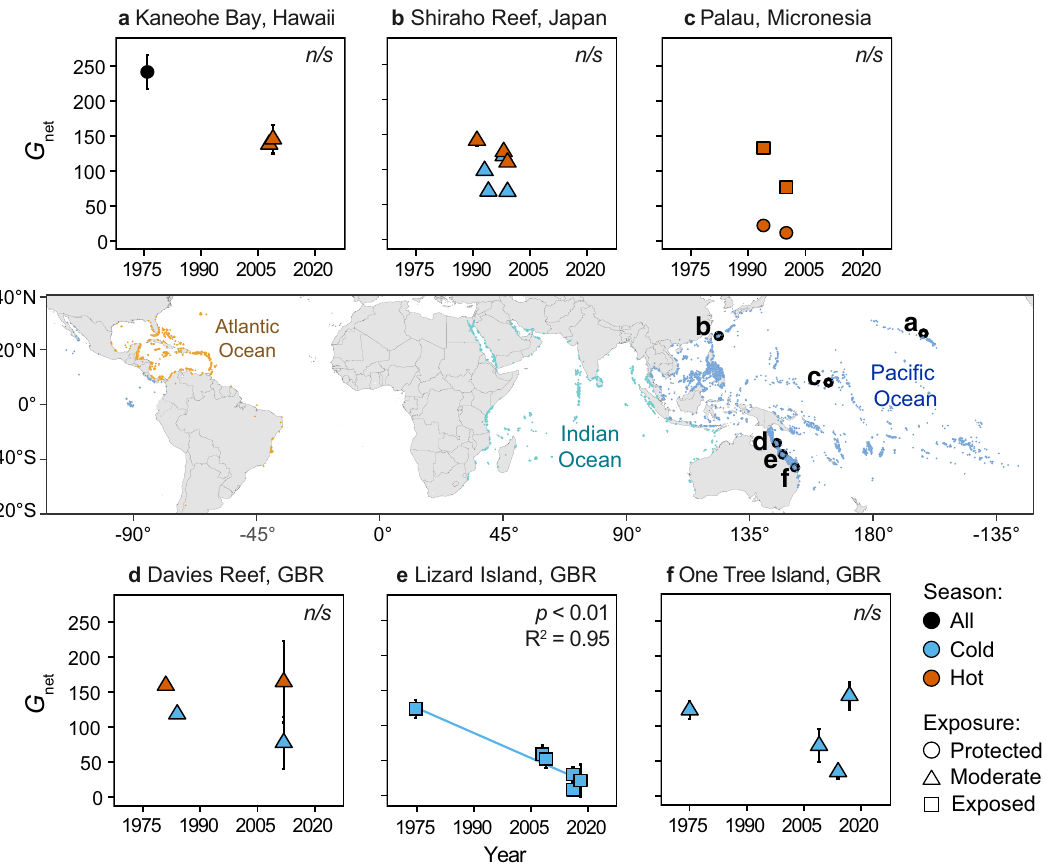
Fig. 1 Global changes in coral reef ecosystem calci fi cation ( G net ) over time. Trends in the subset of repeated measures surveys ( n = 29) used by Davis, footprint of coral reefs where colours denote the three main biogeographic regions: Paci fi c, Indian, and Atlantic Oceans.